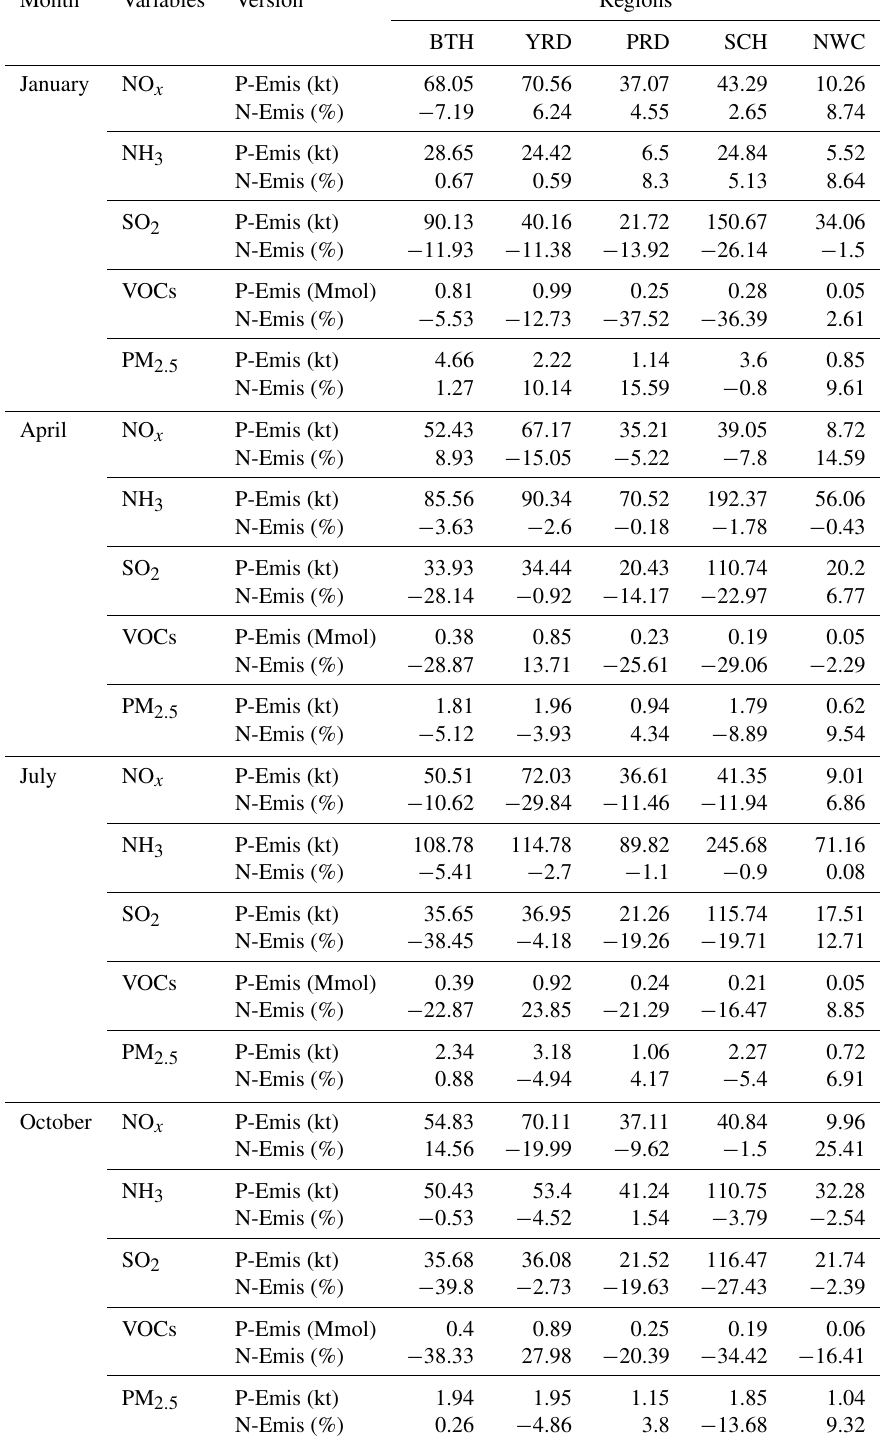
Table 3. Emissions and change ratios in five typical regions for 4